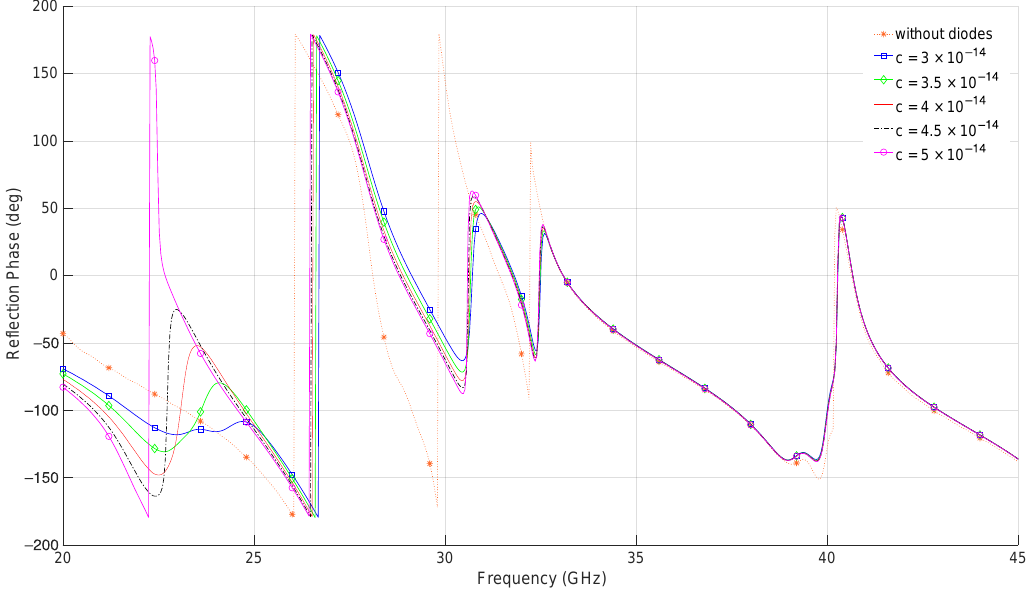
Figure 8. Reflection phase of the 16 element metasurface array with and without PIN